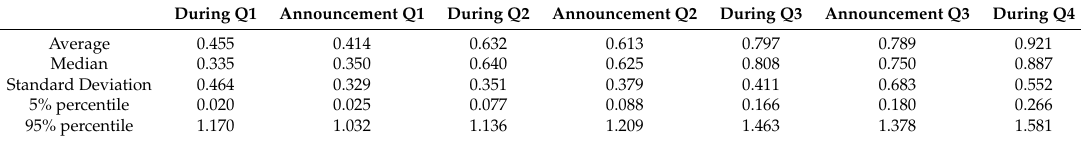
Table 7. A summary of results on median FE 2 , the median ratio of squared analyst forecast error over PCE 2 squared predictable component error. The analyst forecast is the earnings forecast that is reported by an analyst, while the predictable component error is the error made if we use the part of the earnings forecast that we can predict beforehand as forecast. This ratio shows us whether the inclusion of the unpredictable component results in an improvement or not. We show results for 18,338 forecasters across 316 firms, for a total number of 272,970 observations spread over seven periods in the year leading up to the earnings announcement. The seven periods roughly correspond to the periods around the quarterly earnings announcement (excluding the fourth quarter, which coincides with the announcement of the earnings of interest) and the four periods in-between. We take the median ratio per firm to not let a few situations in which the denominator is almost zero influence the measure